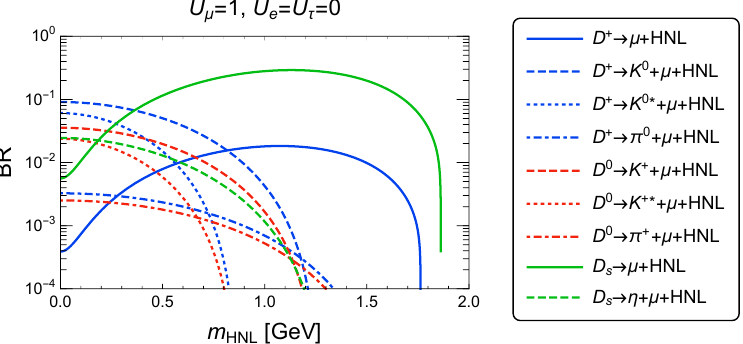
Figure 17 . The same plot as figure 14 but for U µ = 1 , U e = U τ = 0